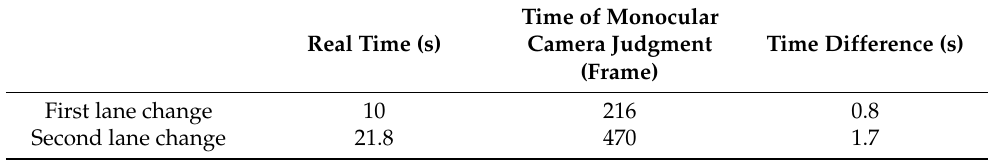
Table 2. Lag time of monocular camera lane change judgment.